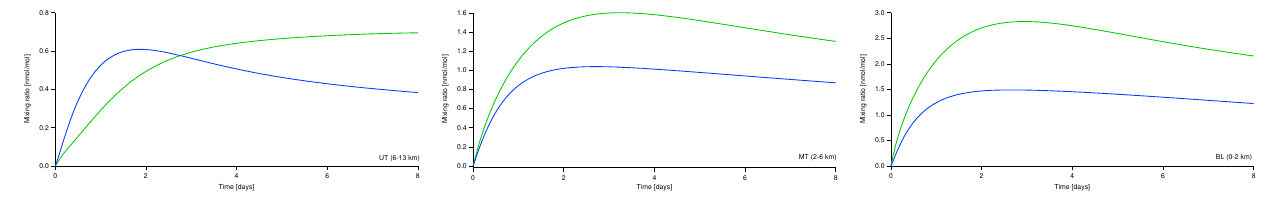
Fig. 12. Mixing ratios for H 2 O 2 (blue line) and CH 3 OOH ∗ (green line) from CAABA for the upper troposphere. Production is initialised from zero and shown for three different height intervals.